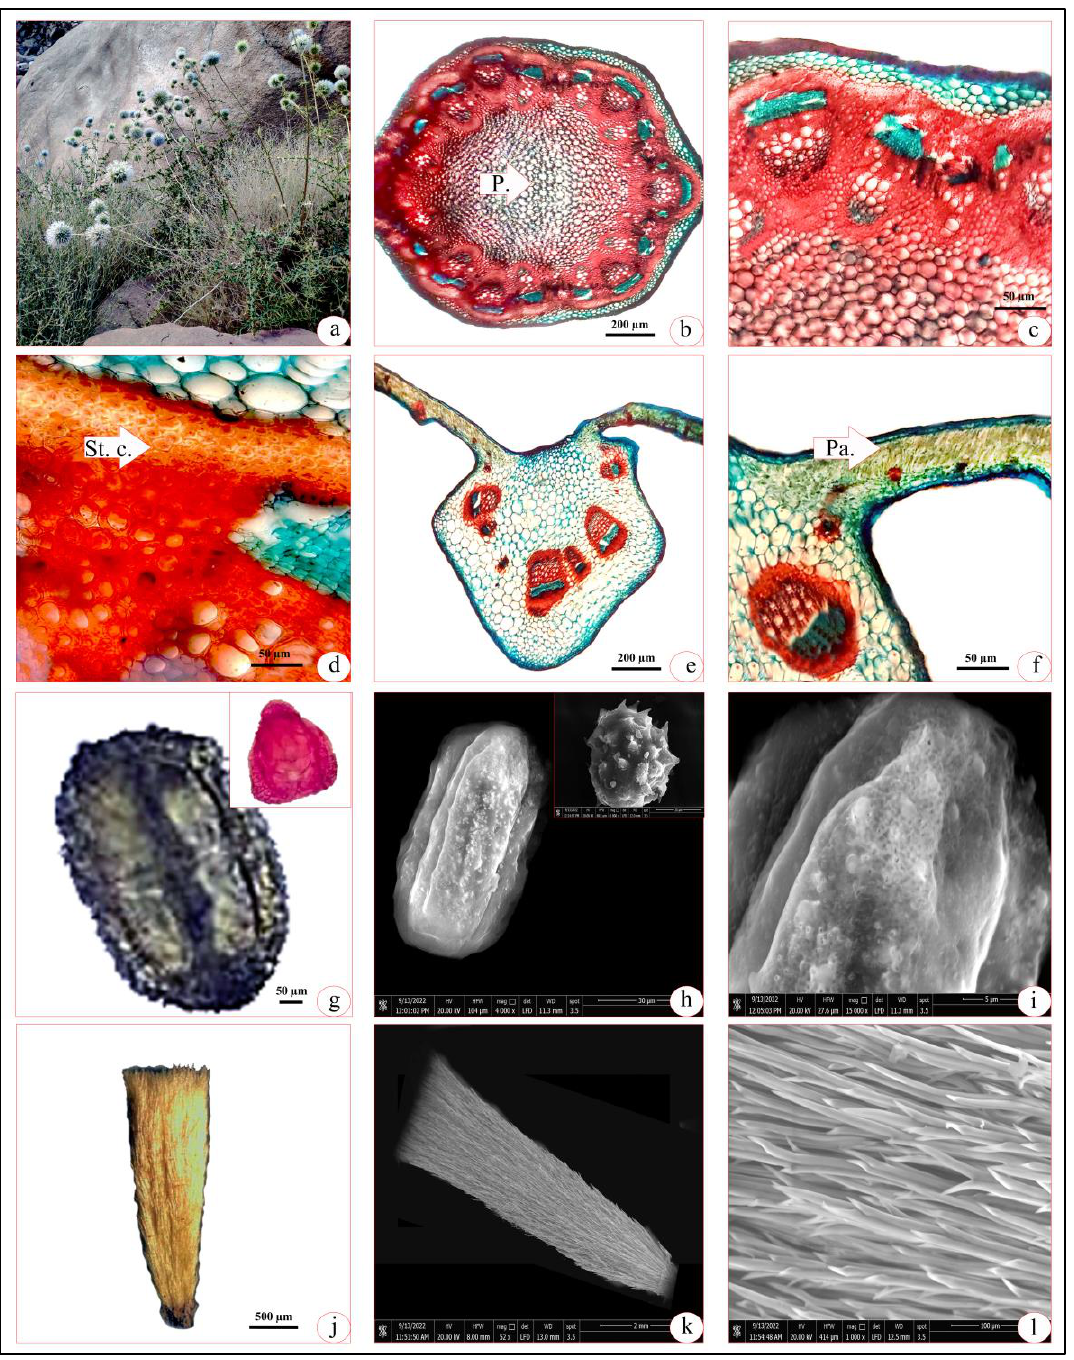
Figure 2. Macro- and microphotographs of the studied taxa: ( a ). Whole plant ( b – d ). Stem cross- section ( e , f ). Lamina vertical section ( g – i ). Pollen morphological characters (LM and SEM) ( j – l ). Achene morphological characters (LM and SEM). P — pith; Pa. — palisade layer; St. c. — stone cell.